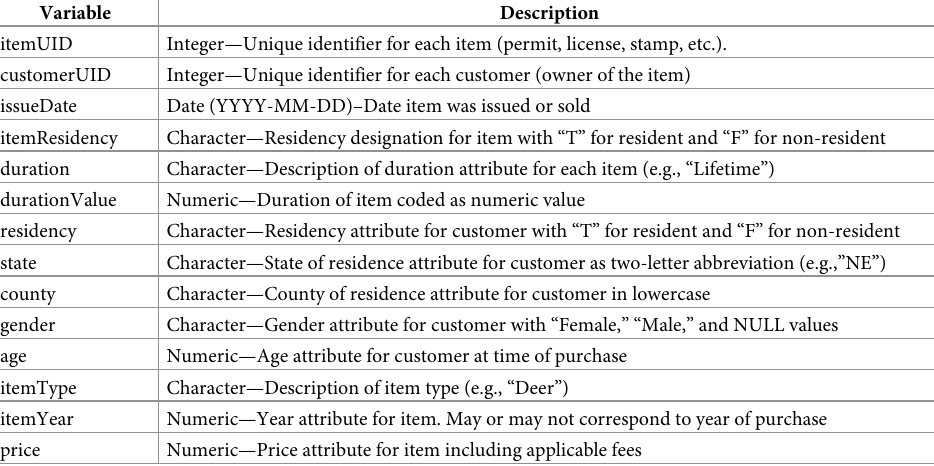
Table 1. Description of required variables and formatting for the "huntfishapp"